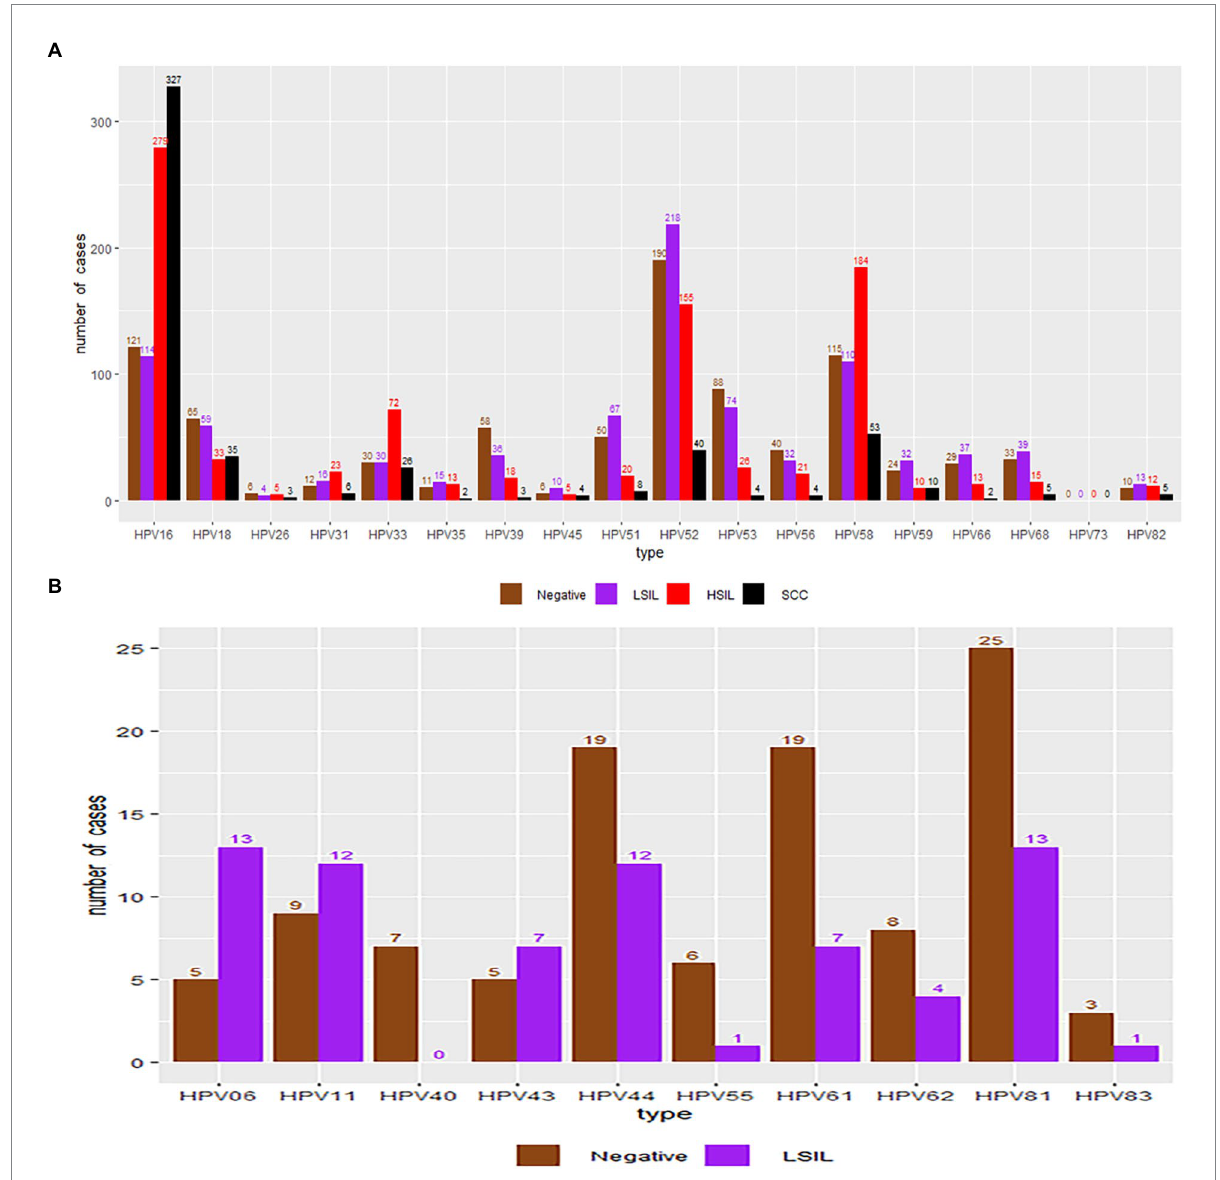
FIGURE 6 HPV genotype infection rates in the negative, LSIL, HSIL and SCC groups. Each bar represents the number of infections due to the corresponding HPV genotypes. Grey, violet, red and black represent negative results, LSIL, HSIL and SCC for the corresponding genotype, respectively. (A) High- risk HPV genotypes with pathological results. (B) Low-risk HPV genotypes with pathological